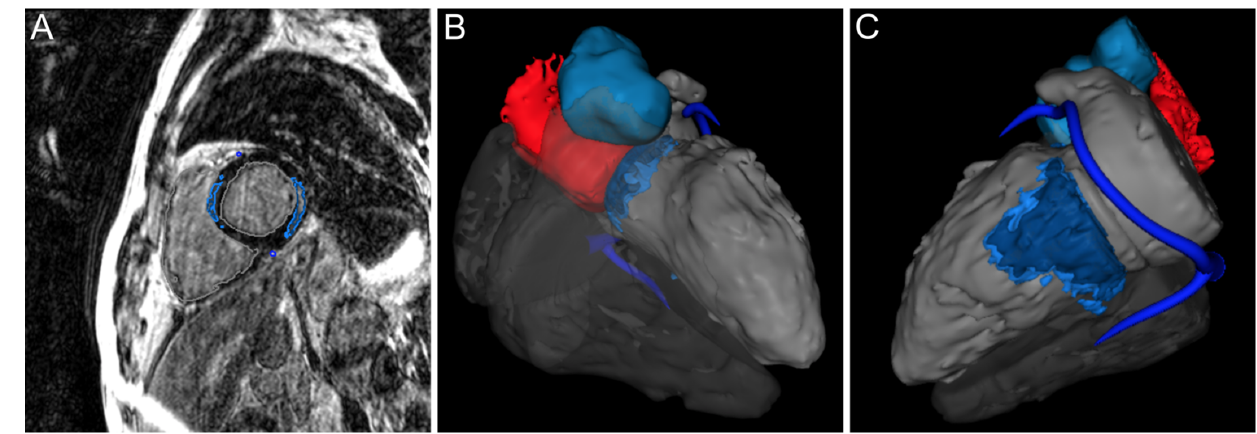
Figure 5. Pre ‐ procedural imaging guides catheter ablation in patients with myocarditis. Exemplary case of a patient with myocarditis who presented with symptomatic premature ventricular complexes (inferior axis, positive in lead I) and non ‐ sustained ventricular tachycardia (CL 258 ms). The patient underwent CMR for 3D imaging acquisition before catheter ablation. ( A ) Short ‐ axis view of CMR depicting dense scar in a septal and lateral area. ( B , C ) 3D reconstruction of CMR guides intra ‐ procedural electroanatomic mapping and catheter ablation. Mapping in the right ventricular outflow tract demonstrated earliest activation (42 ms) in the area of septal dense scar and ablation at this localization resulted in complete suppression of premature ventricular complexes and non ‐ sustained ventricular tachycardia. CMR, cardiac magnetic resonance imaging.